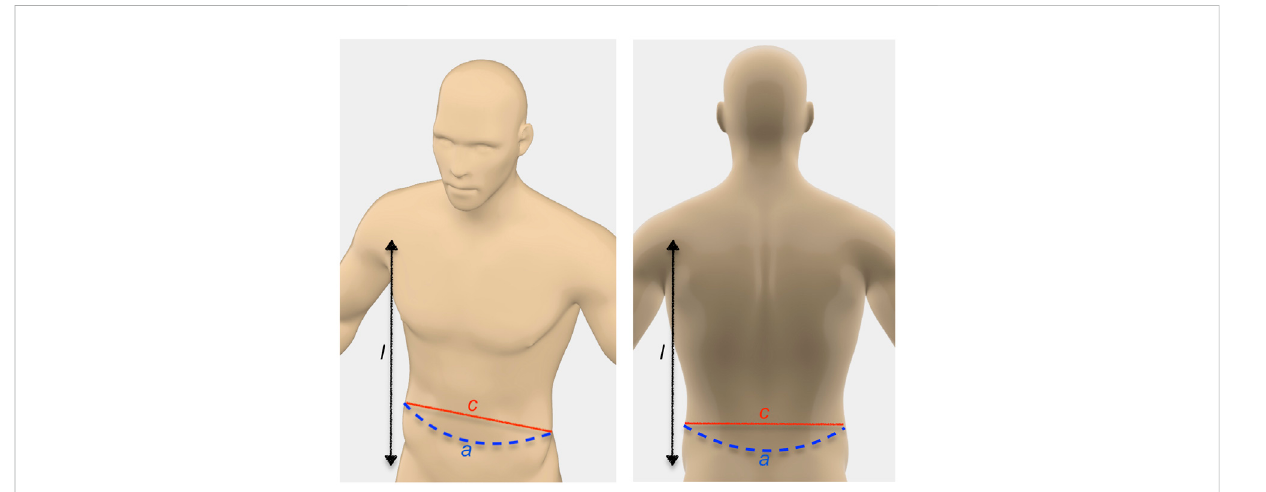
FIGURE 3 Parameters to approximate the patient ’ s limb and body surfaces.